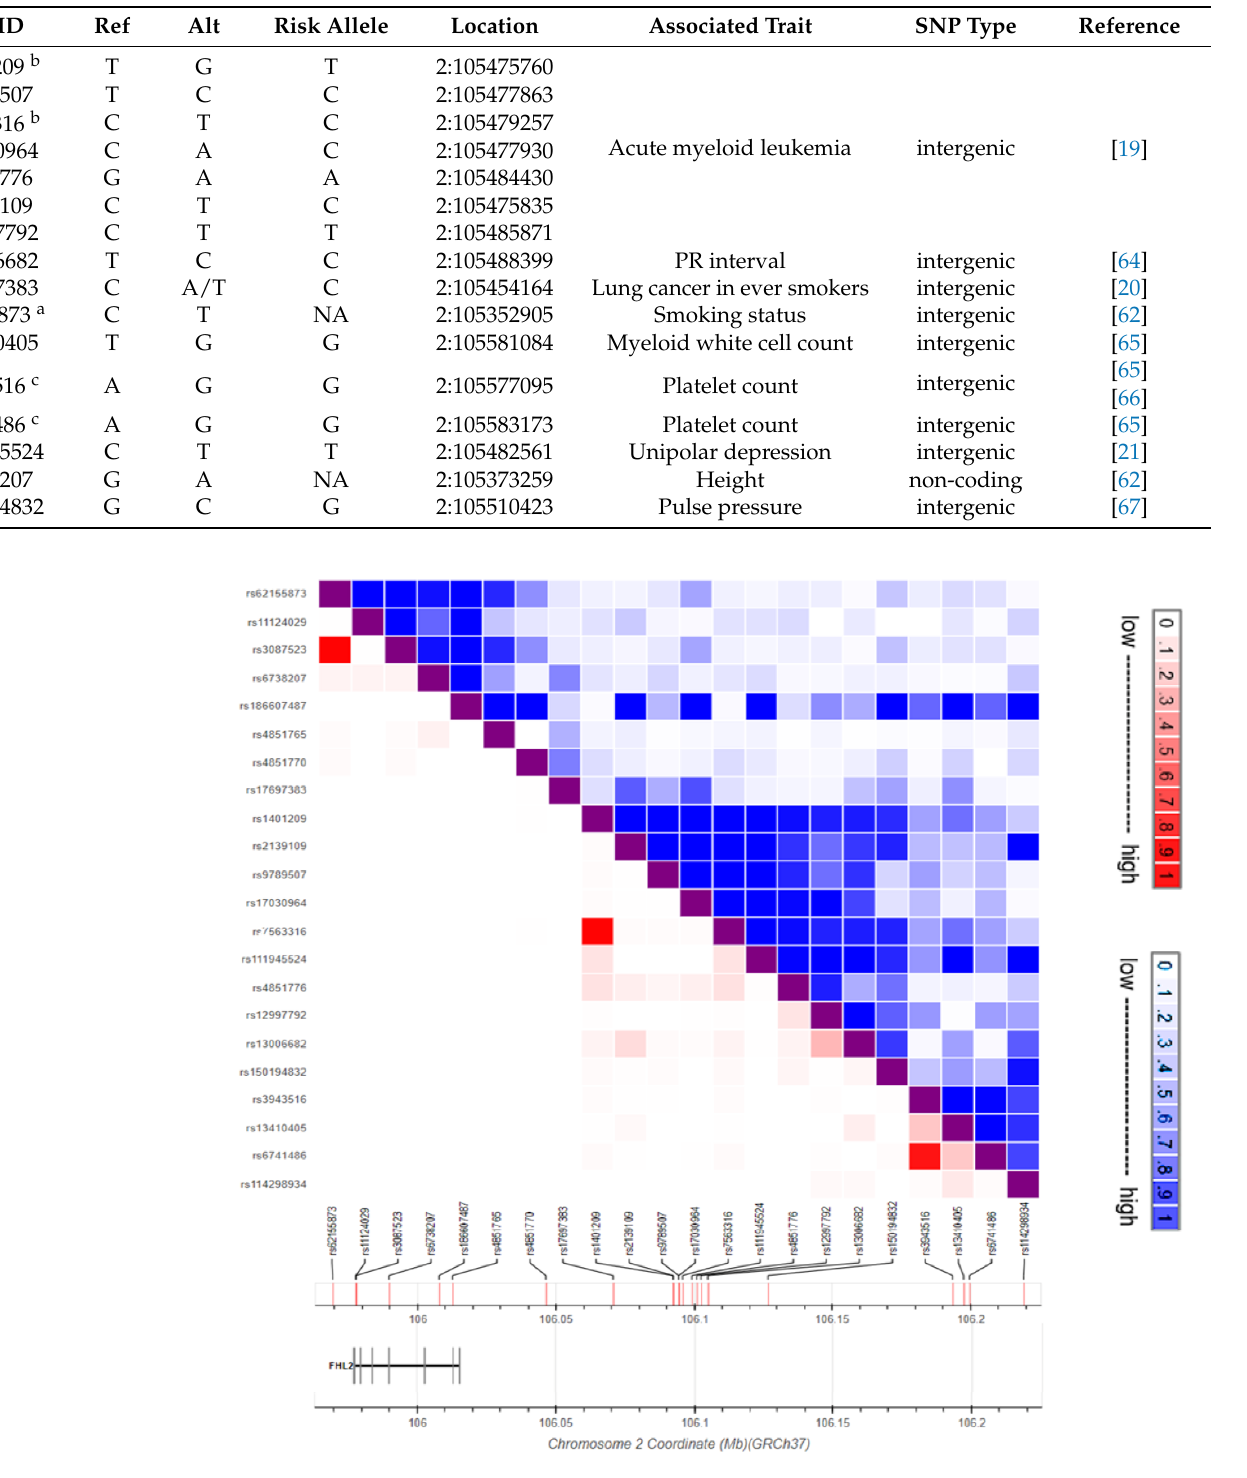
Figure 3. Schematic representation of SNPs in an LD matrix and their localization on chromosome 2, with the FHL2 gene indicated at the left (GrCh37). SNPs with high LDs are indicated in red (R 2 ) and blue (D’). Figure adapted from LDlink. Table 1. FHL2 SNPs and associated traits. The table denotes the FHL2 genetic polymorphisms that are associated with a disease or trait, according to the literature. Here, we indicate the reference allele (Ref), the alternative allele (Alt), the location of the SNP on chromosome 2 (Location), the associated trait, whether the SNP is within the coding, non-coding, or intergenic region (SNP type), and the reference article (Reference). SNPs rs3087523 and rs62155873 (a), rs1401209, and